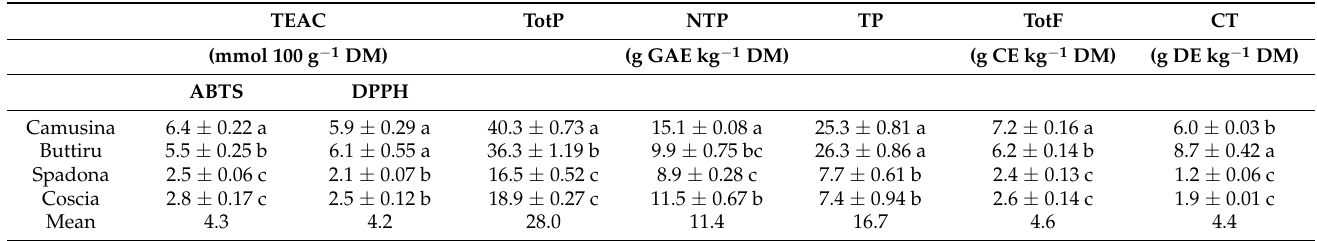
non-tannic phenolics (NTP), tannic phenolics (TP), total flavonoids (TotF), and condensed